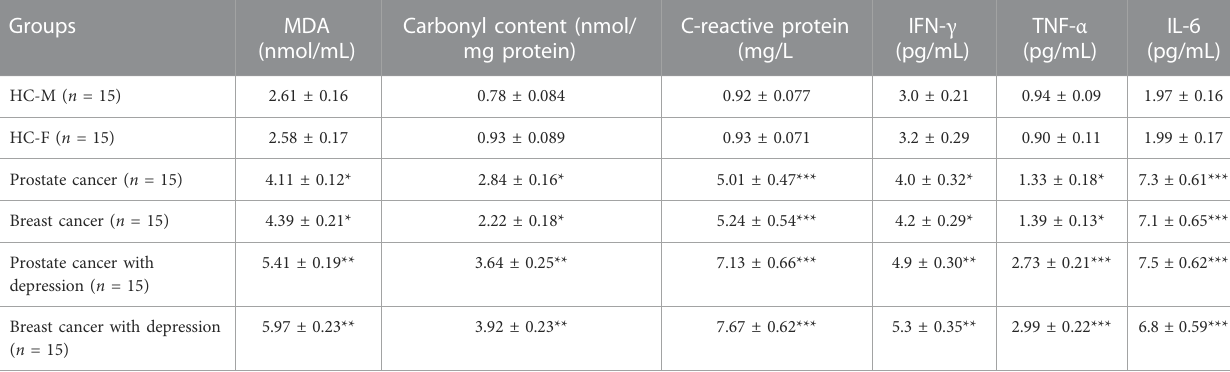
TABLE 2 Oxidative stress, in fl ammatory marker, and in fl ammatory cytokines analysis of cancer patients and healthy subjects. Groups